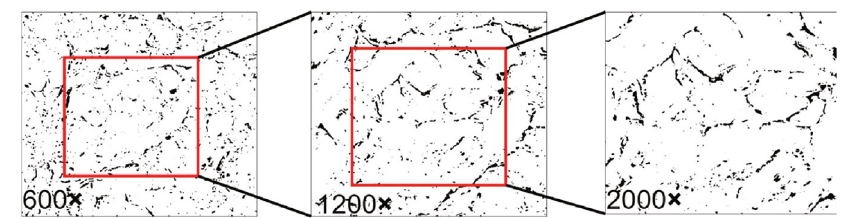
Figure 6: SEM images after segmentation.